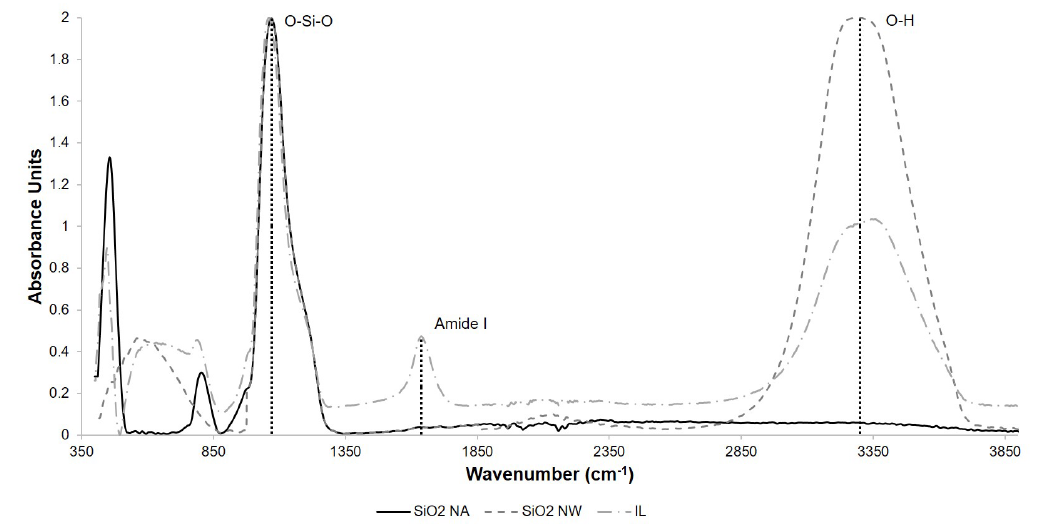
Figure 4. FT-IR analysis of silanized nanoparticles and immobilizates silica-laccase. The presence of the peak at 1087 cm − 1 corresponds to the O-Si-O bond and corroborates e ff ective silanization. Immobilization of laccase (nanocomposite IL) was confirmed by the presence of the amide I band at around 1640 cm − 1 .